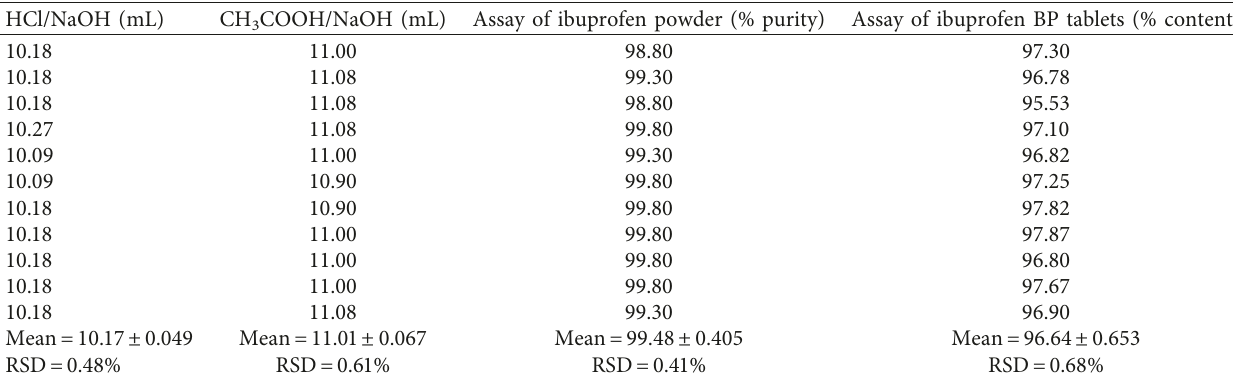
Table 3: Evaluation of